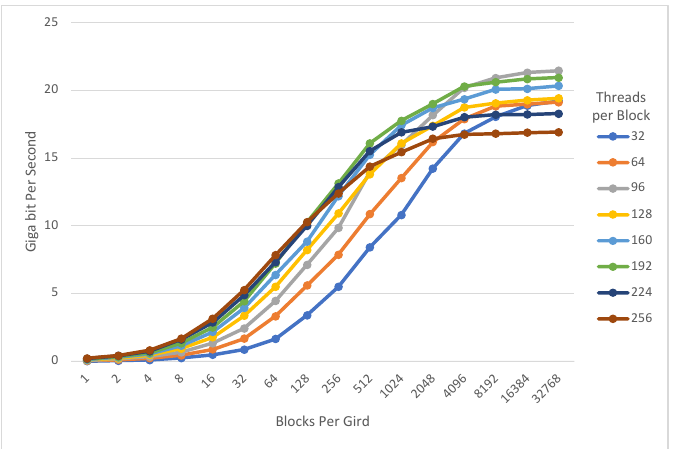
Figure 11. GIFT-128 encryption: Comparison of the number of encryption per